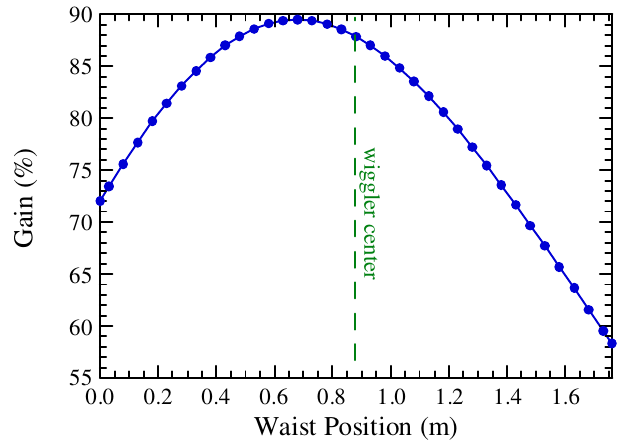
FIG. 6. (Color) Variation of the single pass gain with the posi- tion of the optical waist.